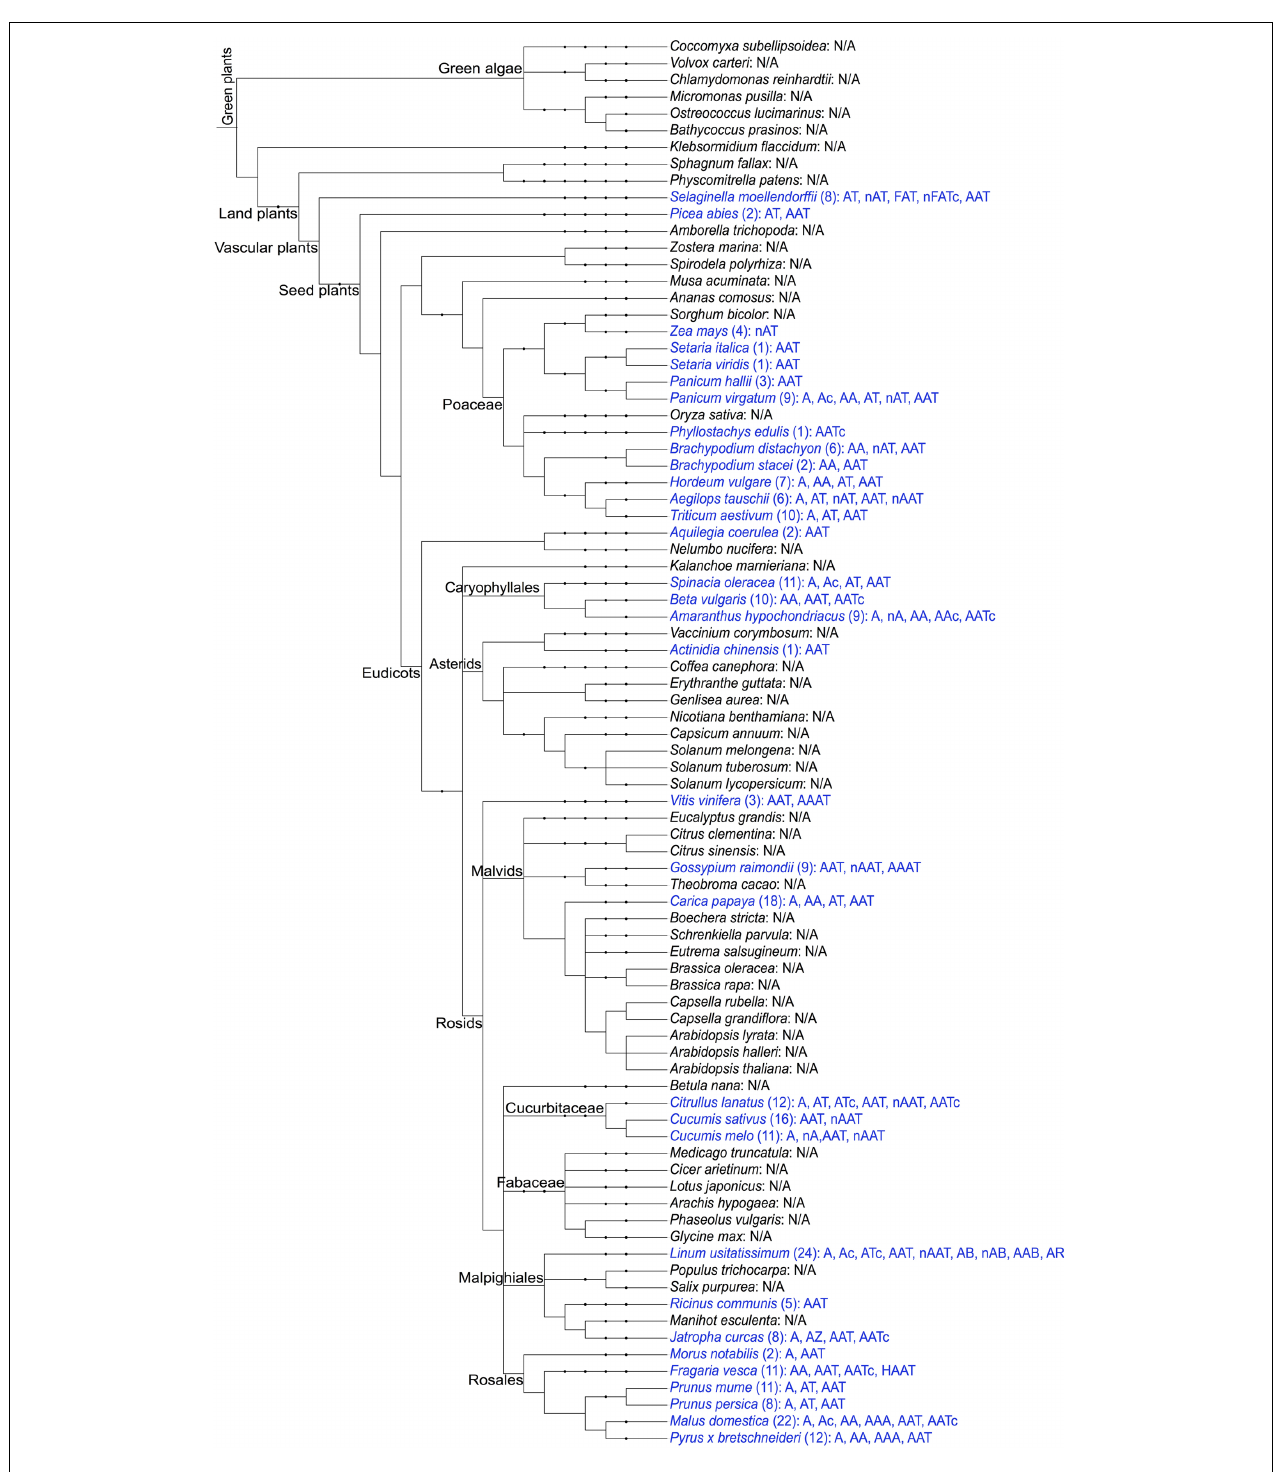
FIGURE 1 | Schematic overview of the distribution of amaranthin domains in the sequenced plant genomes. The taxonomic tree of plant species was generated using PhyloT (http://phylot.biobyte.de/) based on the NCBI taxonomy and visualized through Interactive Tree of Life (iTOL: http://itol.embl.de/). The plant species with amaranthin domains are shown in blue and the number of sequences and their domain architectures are indicated after the names. N/A refers to not applicable, indicating that no amaranthin domain was retrieved from this species. Abbreviations in the domain architectures—n, N-terminal domain ( > 50 aa); c, C-terminal domain ( > 50 aa); A, amaranthin domain; T, aerolysin domain; F, fascin domain; B, Bet v1 domain; R, TRAF-like domain; H, alpha/beta hydrolase domain; Z, B-box type zinc finger